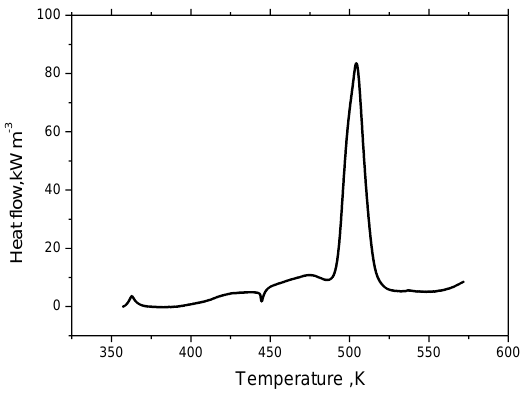
Figure 1. The heat flow curve of 50 Ah battery extracted from the C80 heat flow of a CR2032